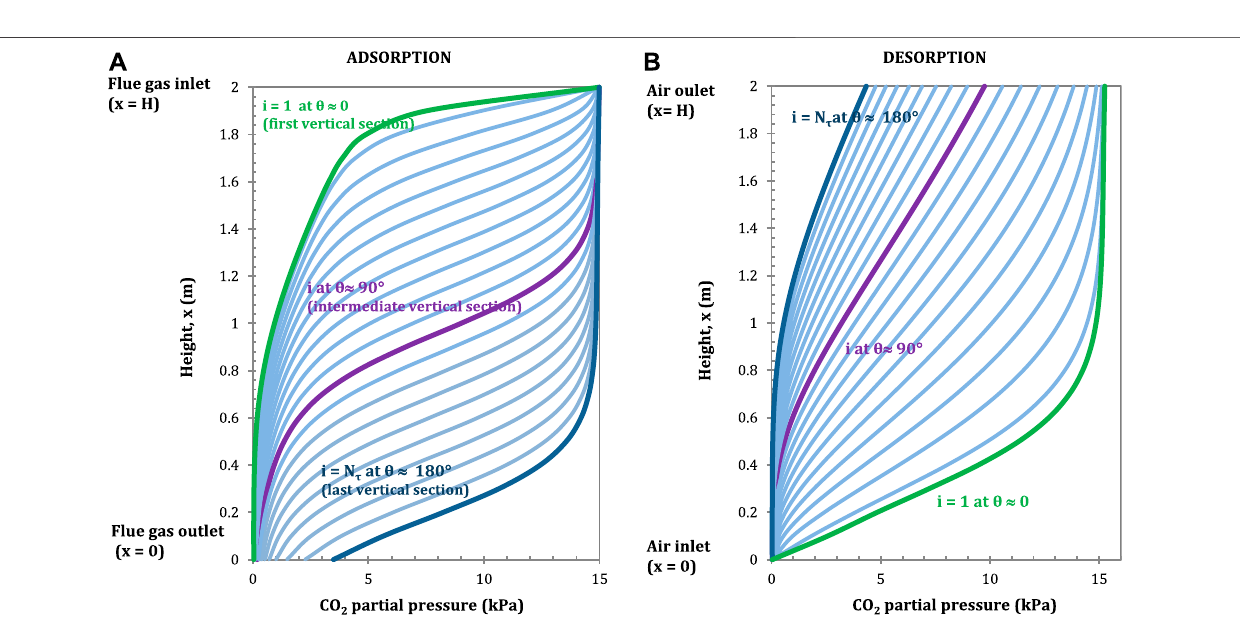
FIGURE 5 | CO 2 partial pressure pro fi les in the fl ue gas (A) (adsorption) and in the air, (B) (desorption) in longitudinal direction for each vertical section. Con fi guration: S-EGR in parallel at 70% recirculation ratio. Adsorbent: Activated Carbon.